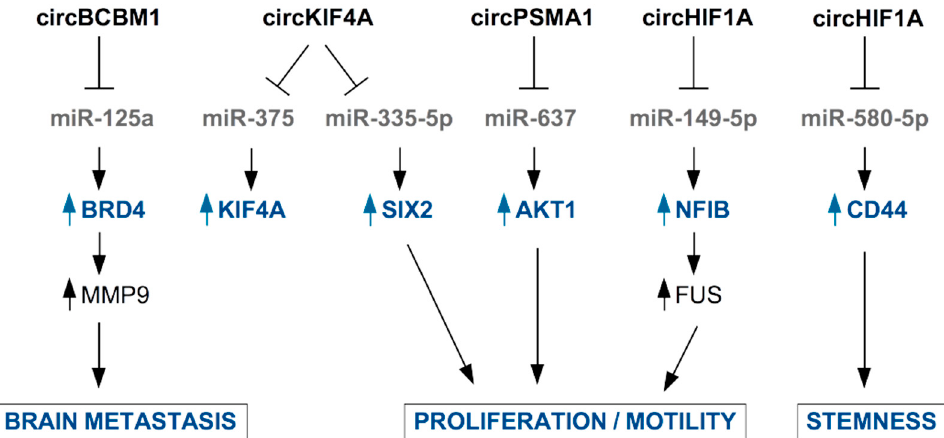
Figure 4 . Examples of circRNAs secreted in EVs by TNBC cells or by CAFs and their functional role in TNBC cells. CircRNA are mainly involved in the inhibition of the function of microRNAs through sponging activity. This results in released expression of miRNA’s target mRNAs and enhancement of pro-tumoral